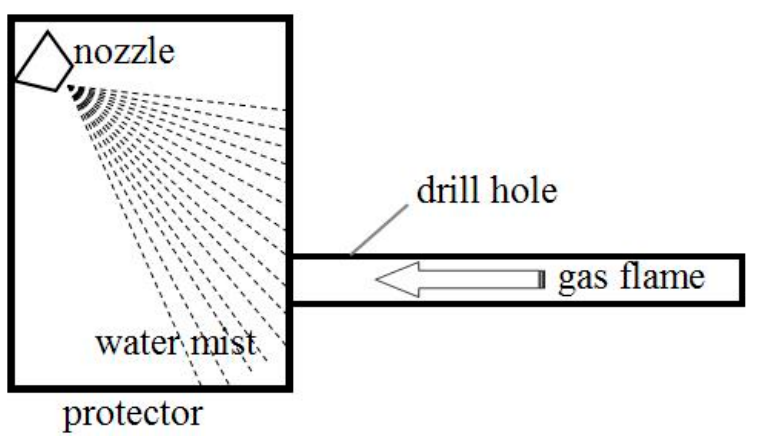
Table 1. The change of gas concentration test results on the working surface. Condition